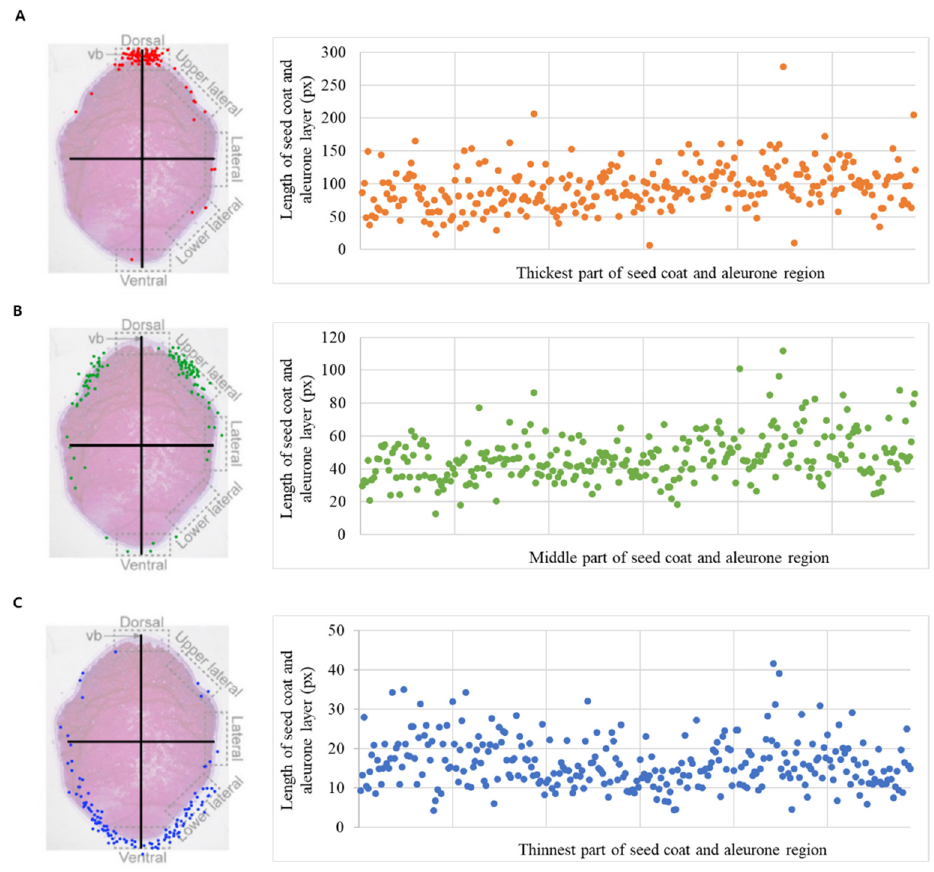
Figure 1. Scatterplot of seed coat and aleurone layer thickness by region, in the 294 rice resources. ( A ) the thickest part, ( B ) middle part, and ( C ) the thinnest part. The cross-section of seeds was classified into a total of five areas (dorsal, upper lateral, lateral, lower lateral, and ventral) according to half-cut seed method and investigated.